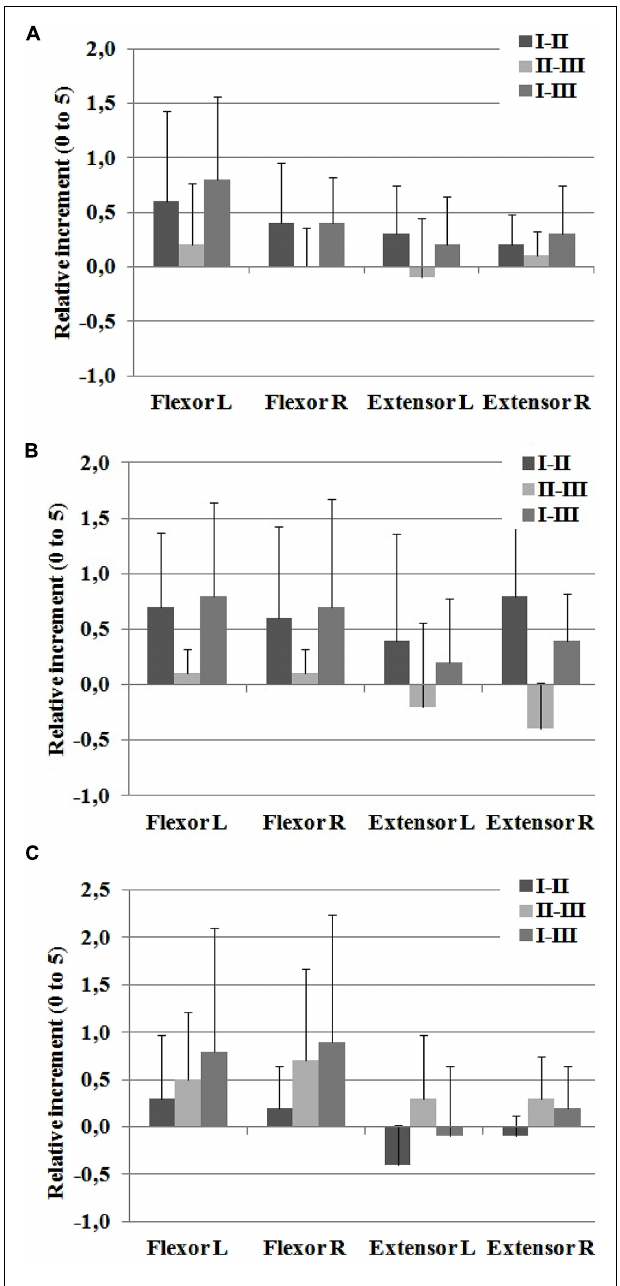
FIGURE 7 | Sagittal manual muscle testing (MMT) score for (A) hip, (B) knee, and (C) ankle joints. The reported data are average and standard deviation of the relative changes between the examination sessions I–II, II–III, and I–III.